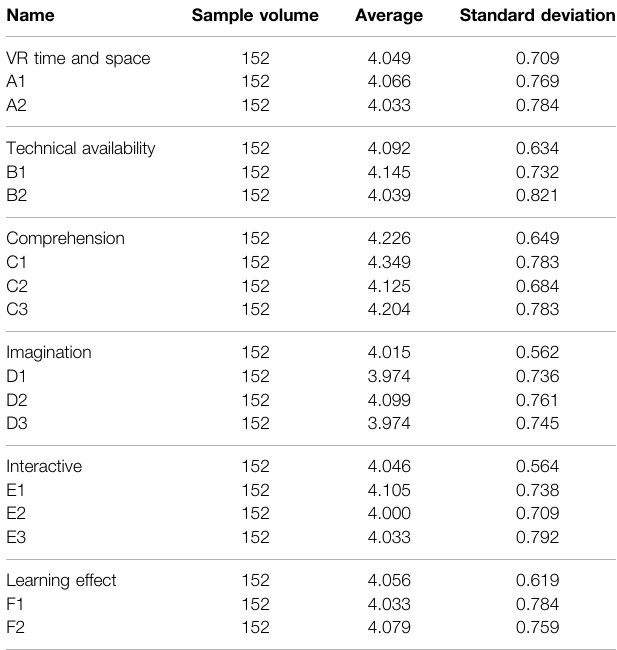
TABLE 5 | Statistical table showing descriptions of learning effect